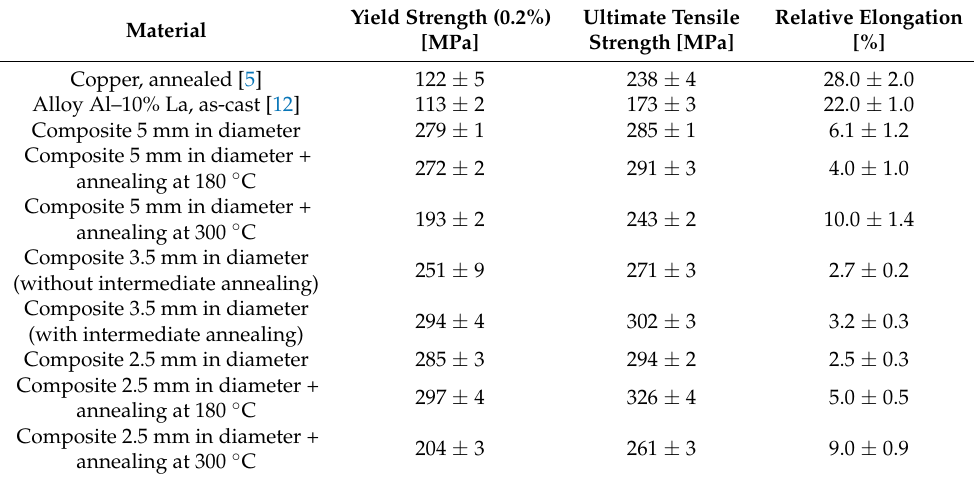
Table 1. Mechanical properties of the composite samples and their components.